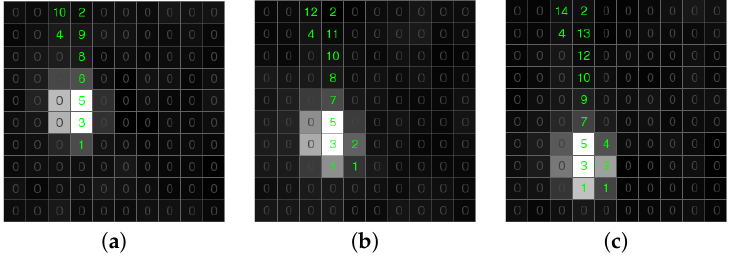
Figure 12. The counters of a positive candidate associated with pixels labeled as a candidate object.